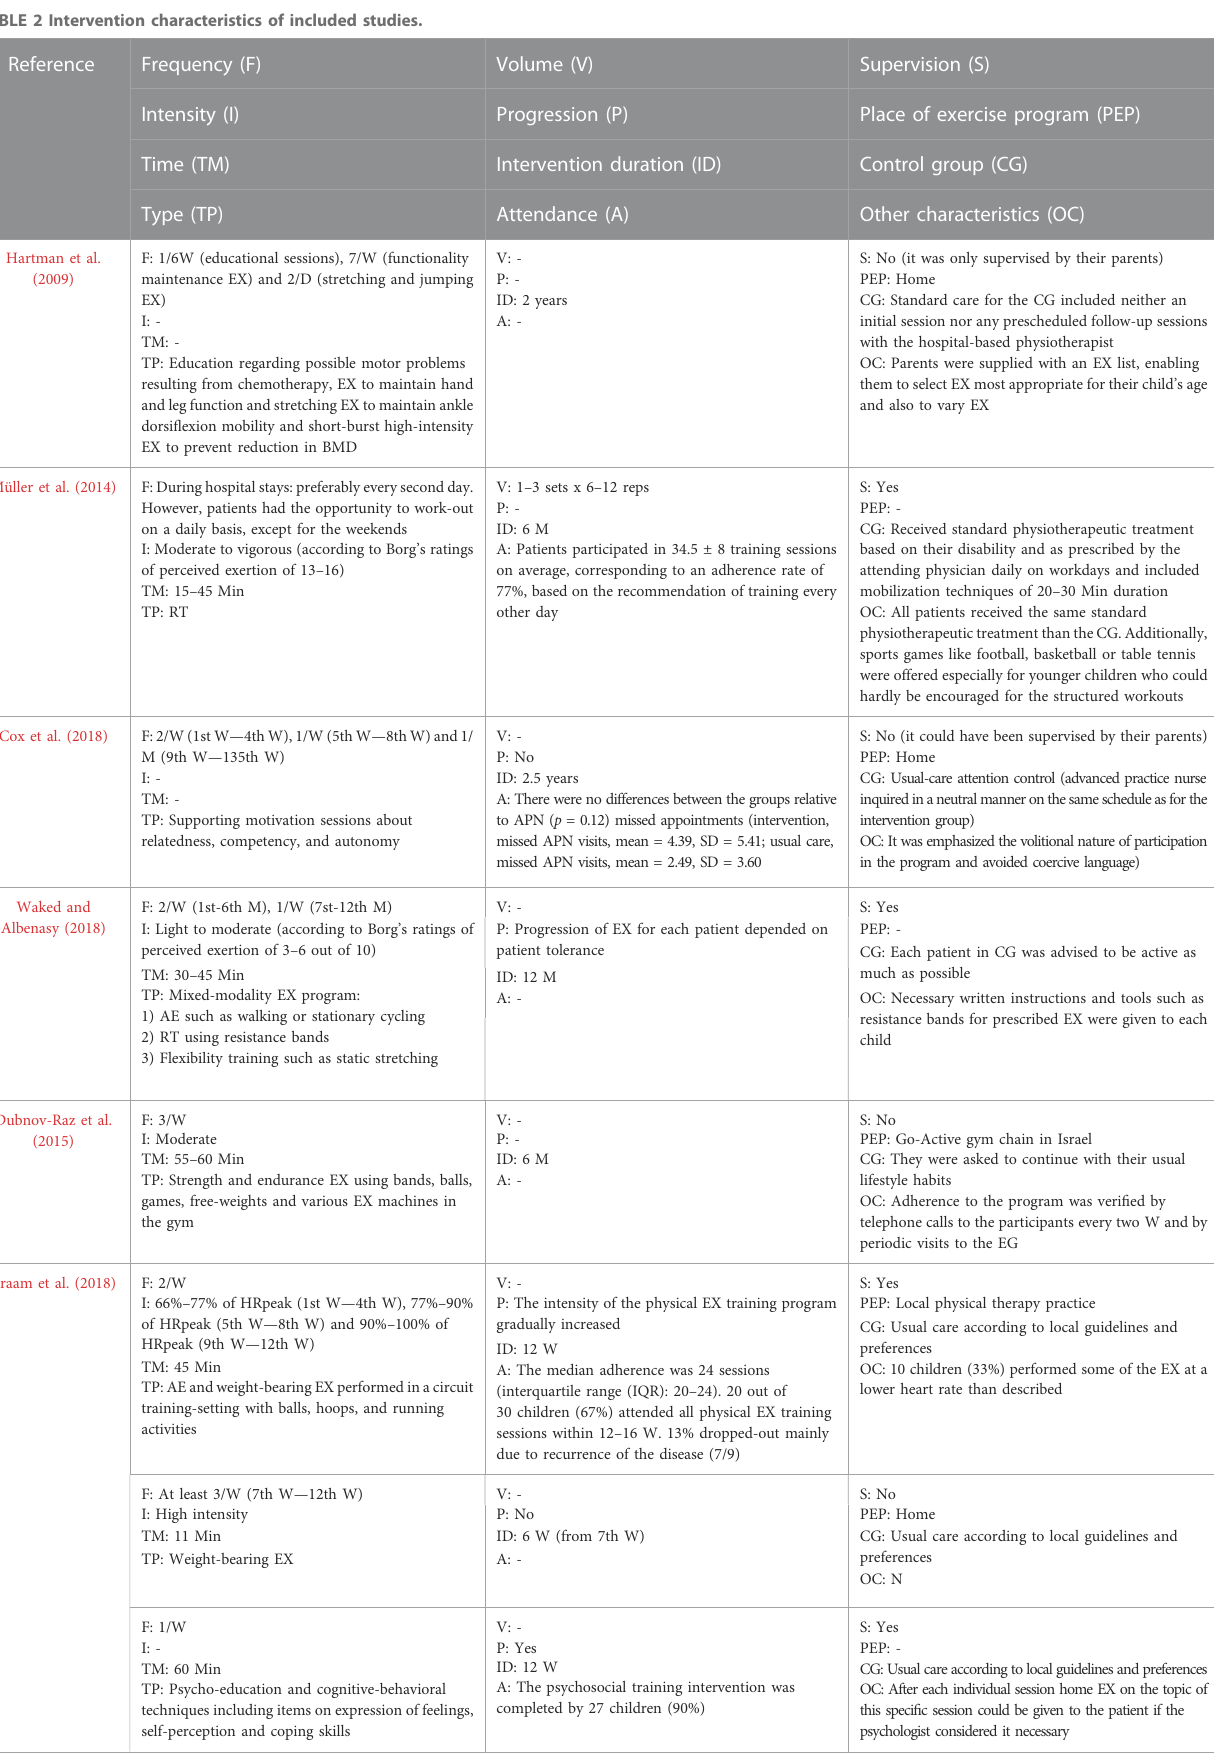
TABLE 2 Intervention characteristics of included